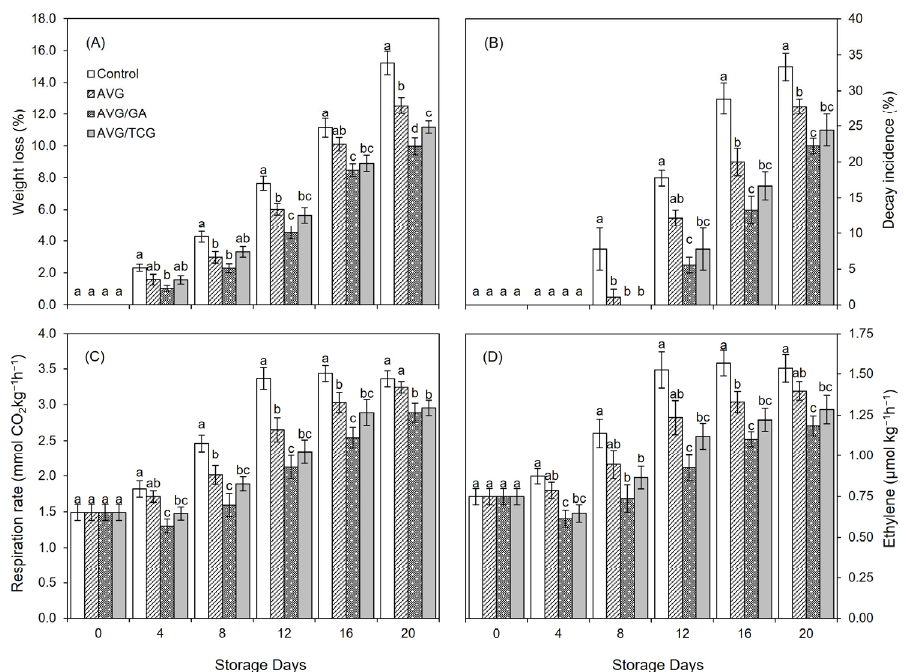
Figure 1. Effect of AVG-based composite coatings on physiological weight loss ( A ), decay incidence ( B ), respiration rate ( C ) and ethylene production ( D ) of persimmon fruits during 20 days storage (analysis on day 0, 4, 8, 12, 16 and 20) at 20 ± 1 °C and 80–85% relative humidity. All standard error bars are centered on means (3 biological replicates). Graph bars sharing same letters on a storage interval have non ‐ significance difference according to the LSD test at p ≤ 0.05.